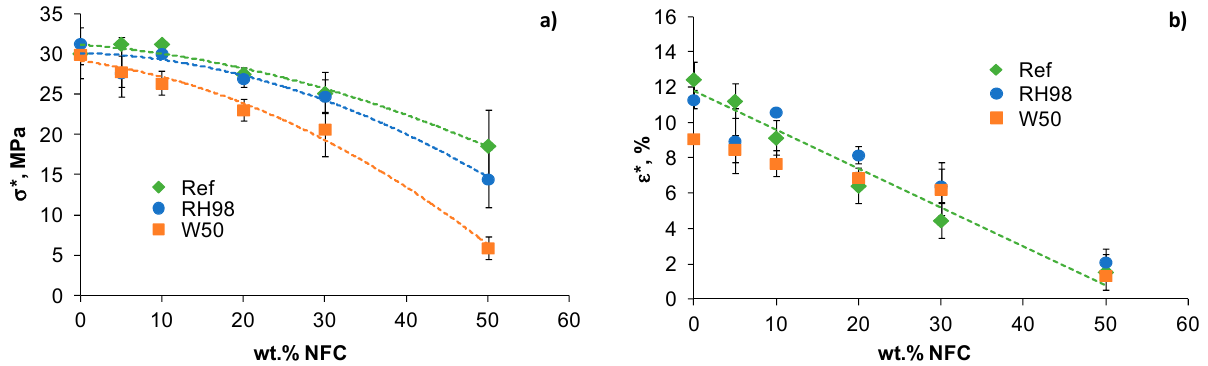
Figure 5. Strength ( a ) and strain at failure ( b ) of PBS/NFC composites as functions of NFC weight content. Lines are approximations.